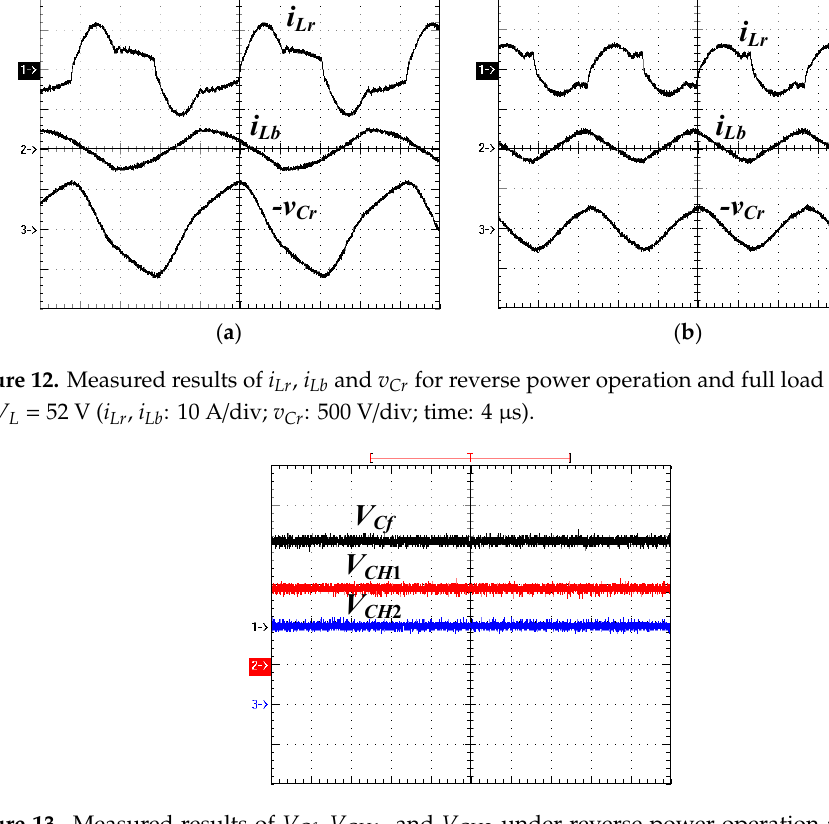
Figure 13. Measured results of V Cf , V CH 1 , and V CH 2 under reverse power operation and full load (v Cf , V CH 1 , V CH 2 , V Da , V Db : 200 V/div; time: 4 μ s).